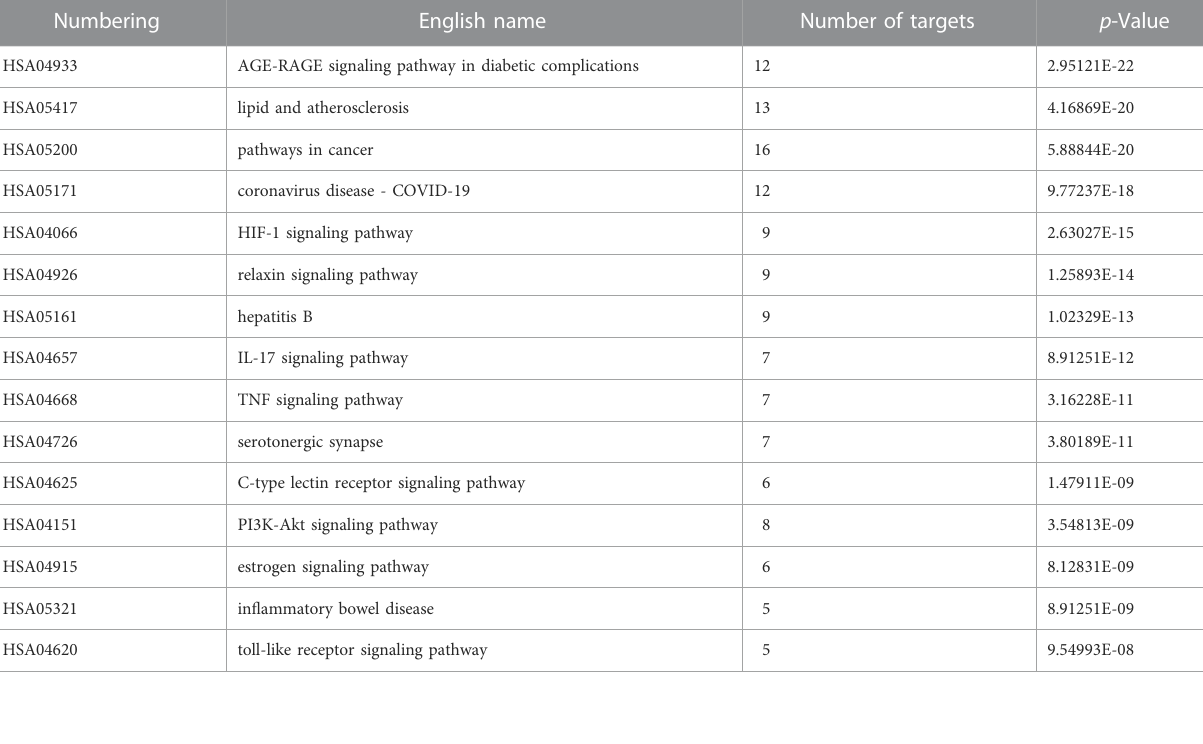
TABLE 8 Results from KEGG pathway enrichment analysis.